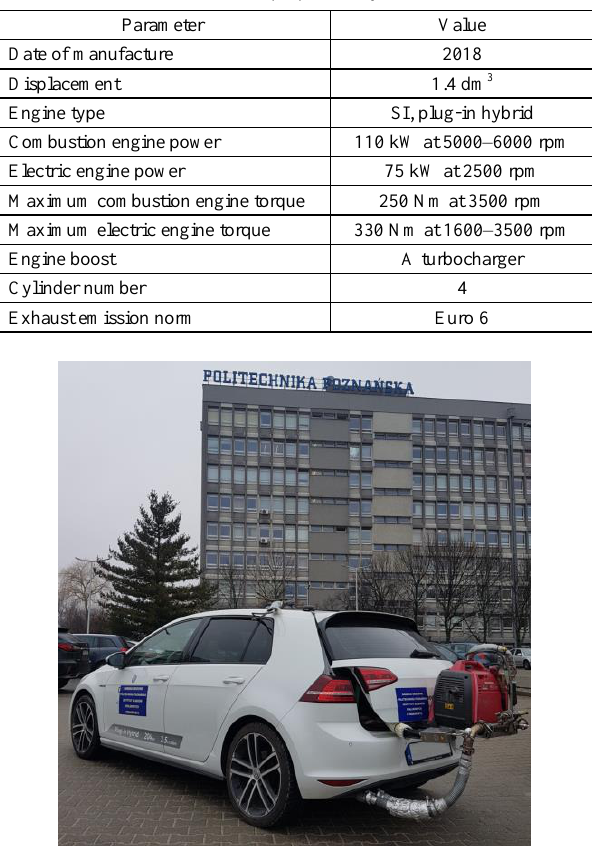
Table 1. Technical data on the propulsion system of the test vehicle